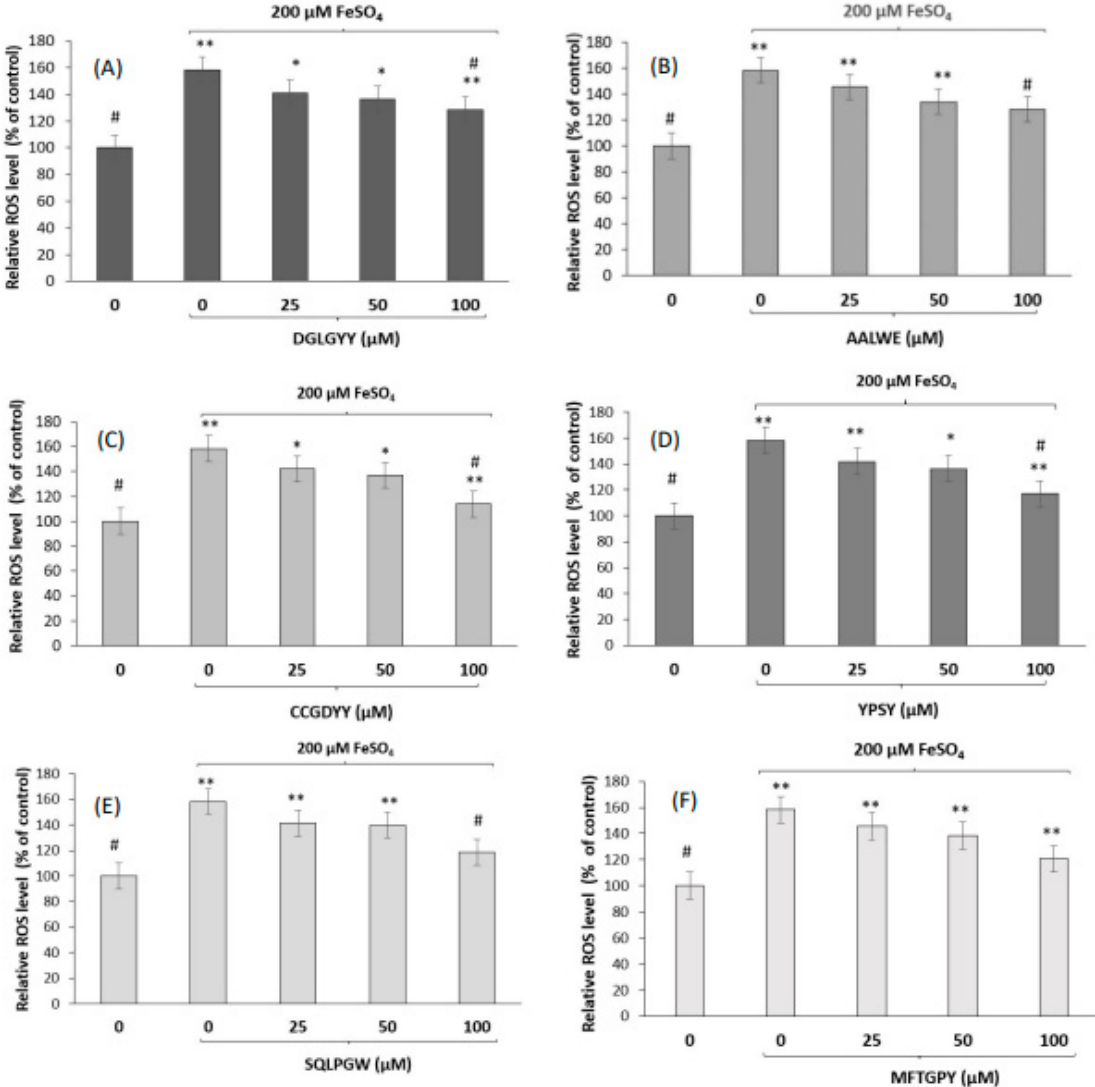
Figure 1. ROS levels (% of control) after the pre-treatment of SH-SY5Y cells with peptides ( A ) DGLGYY; ( B ) AALWE; ( C ) CCGDYY; ( D ) YPSY; ( E ) SQLPGW; ( F ) MFTGPY at different concen- trations (25, 50, and 100 µ M) for 3 h, and induction with FeSO 4 . * p < 0.05, ** p < 0.001 vs. control (non-treated cells), # p < 0.001 vs. FeSO 4 treated